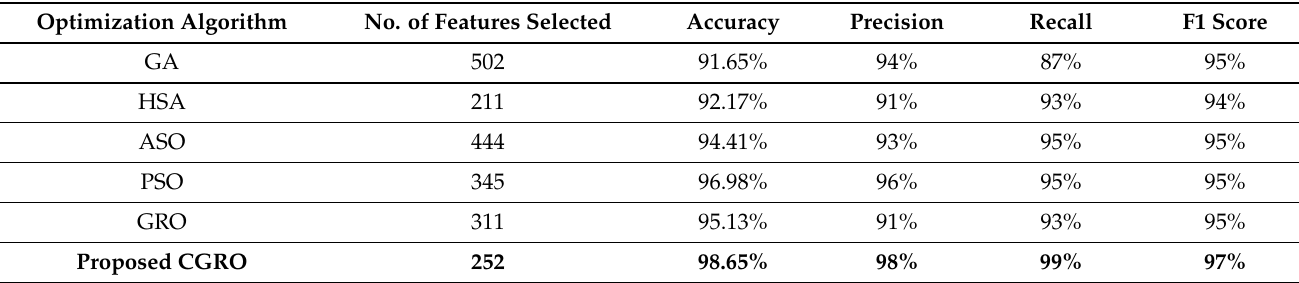
Table 7. Comparative study of different optimization algorithms with proposed CGRO based FS algorithm on SARS-Cov-2 CT-Scan dataset.The performance of proposed algorithm has been highlighted in bold text format. Optimization Algorithm